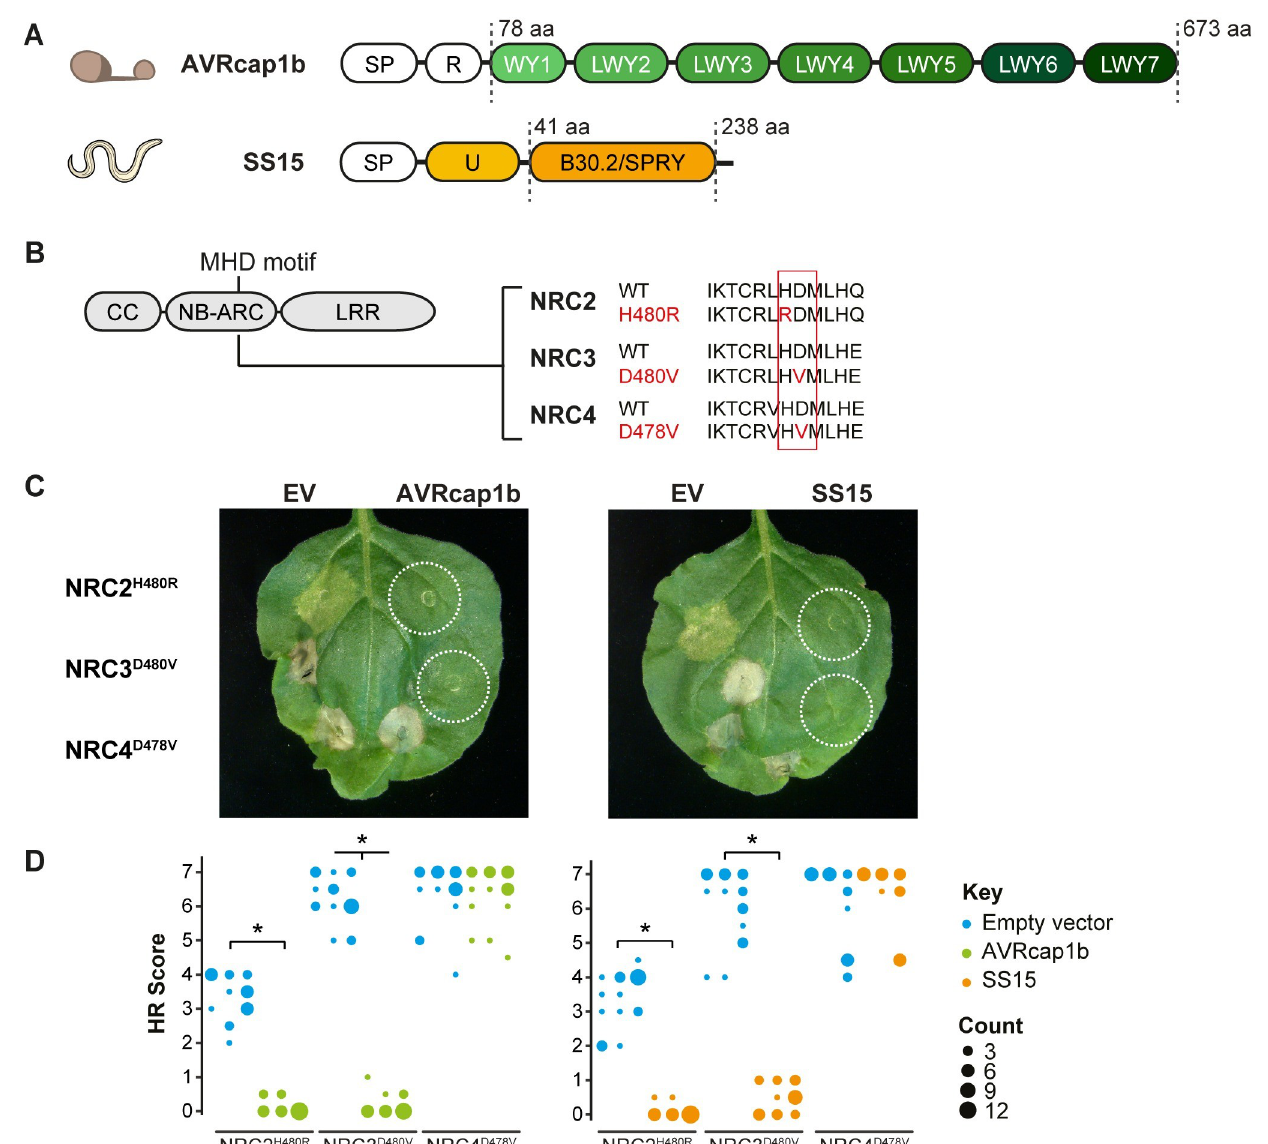
Fig 2. AVRcap1b and SS15 suppress cell death activity mediated by autoactive NRC2 H480R and NRC3 D480V but not NRC4 D478V . (A) Domain organisation of the RXLR-WY/LWY domain containing P . infestans effector AVRcap1b and the B30.2/SPRY (IPR001870) domain containing G . rostochiensis effector SS15, where SP = signal peptide, R = RxLR motif, U = uncharacterized domain. (B) Schematic representation of NRC2, NRC3, and NRC4 and the mutated sites in the MHD motif. Substituted residues are shown in red in the multiple sequence alignment. (C) Representative N . benthamiana leaves showing HR after coexpression of EV, AVRcap1b, or SS15, indicated above leaf panels, with autoimmune NRC2 H480R , NRC3 D480V , and NRC4 D478V mutants. Plants were photographed 5 days after agroinfiltration. (D) HR was scored 5 days post-agroinfiltration (S5 Data). The results are presented as a dot plot, where the size of each dot is proportional to the number of samples with the same score (count) within each biological replicate. The experiment was independently repeated 3 times each with 6 technical replicates. The columns of each tested condition (labelled on the bottom of the plot) correspond to results from different biological replicates. Statistical tests were implemented using the besthr R library [41]. We performed bootstrap resampling tests using a lower significance cutoff of 0.025 and an upper cutoff of 0.975. Mean ranks of test samples falling outside of these cutoffs in the control samples bootstrap population were considered significant. Significant differences between the conditions are indicated with an asterisk ( � ). Details of statistical analysis are presented in S4 Fig. CC, coiled-coil; EV, empty vector; HR, hypersensitive response; LRR, leucine-rich repeat; MHD, methionine– histidine–aspartate; NB-ARC, nucleotide-binding domain shared with APAF-1, various R-proteins, and CED-4; WT, wild type.